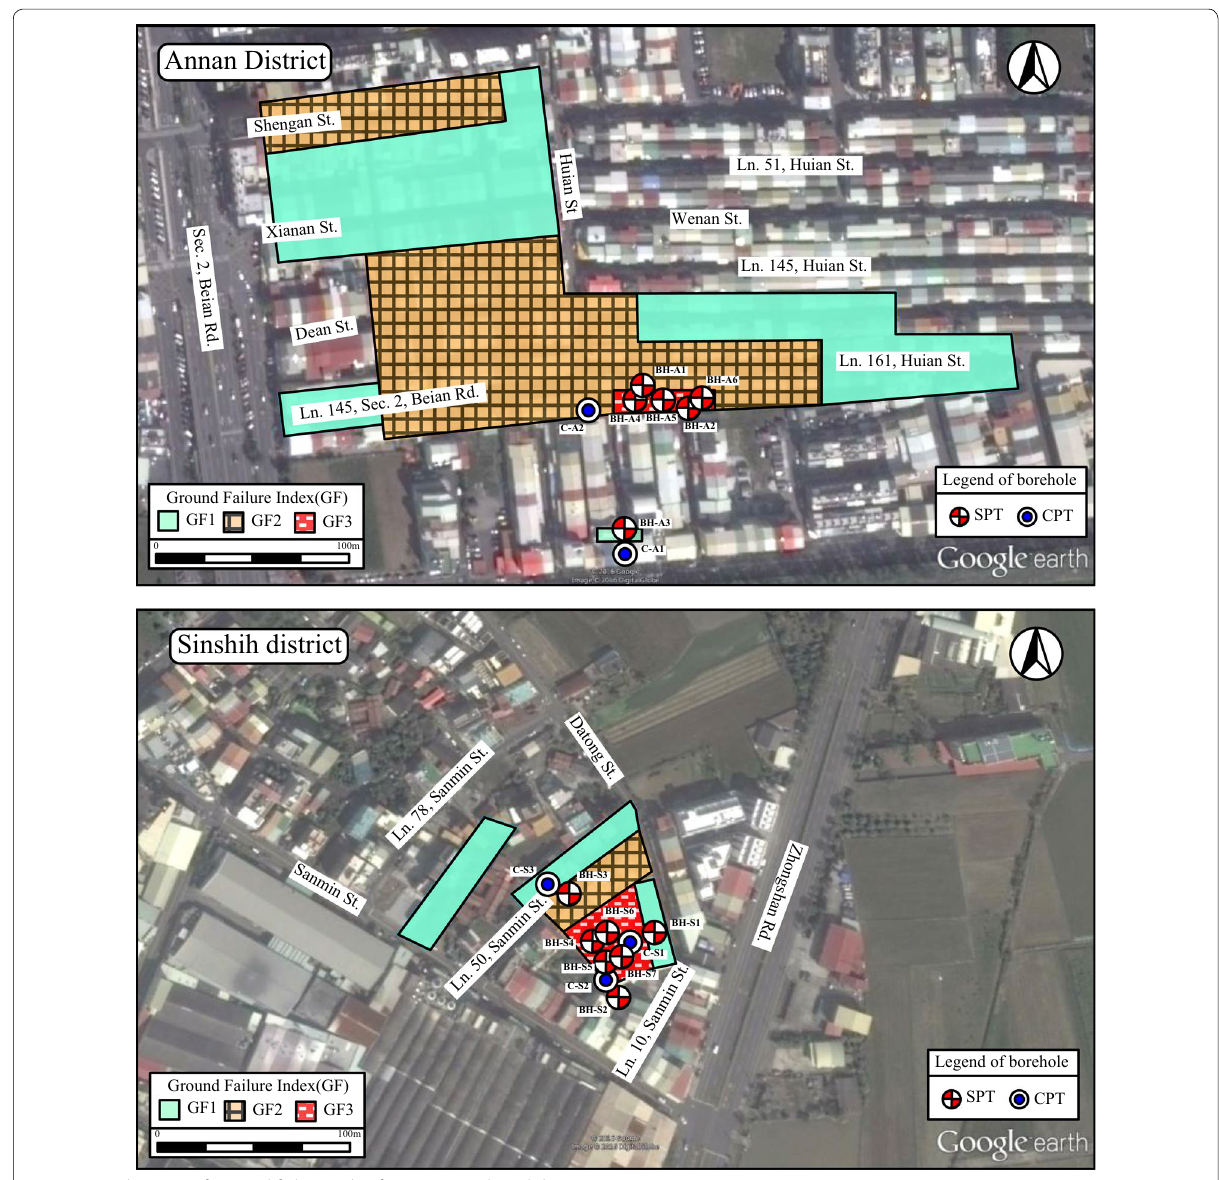
Fig. 2 Distributions of ground failure index for Annan and Sinshih